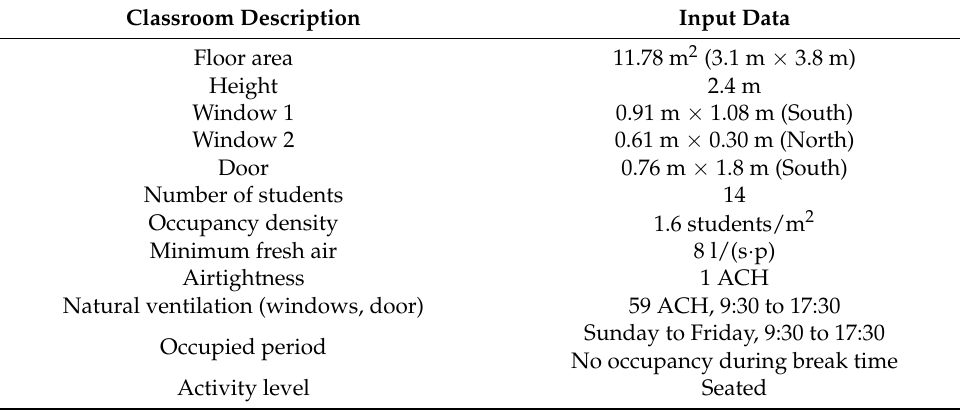
Table 6. Description of the simulated